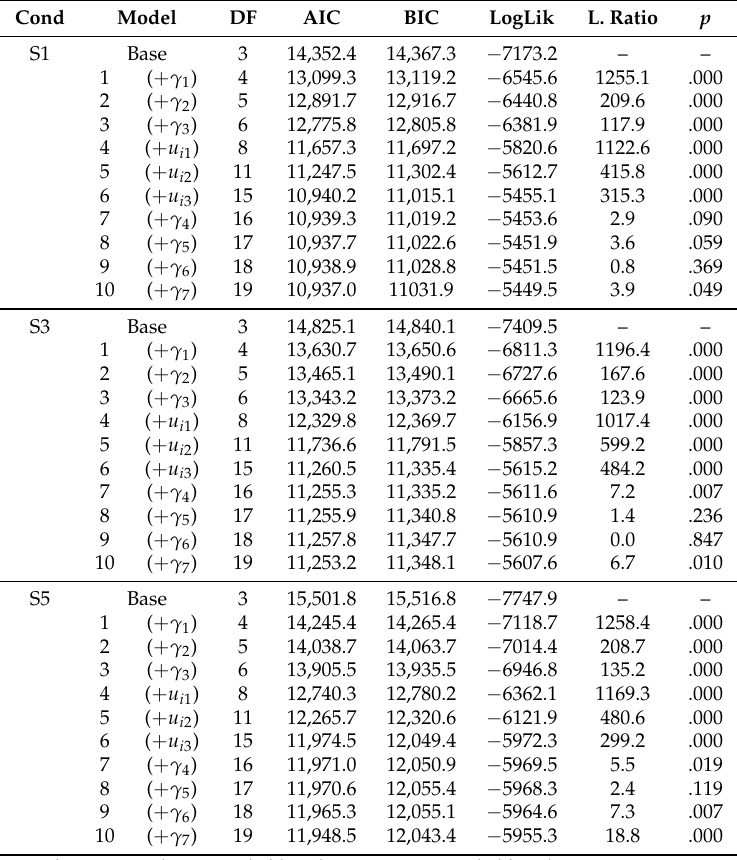
Table 3. Estimates for model fit of the MLM across all three conditions for the WPA with unstandardized regression